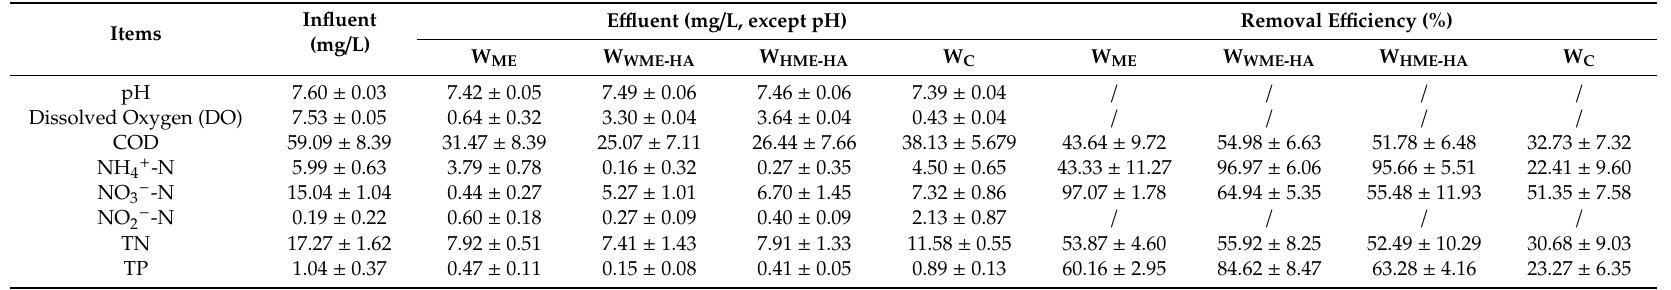
Table 2. The physicochemical characteristics of influent and e ffl uent and related removal e ffi ciency (mean ± standard deviation (SD), n =